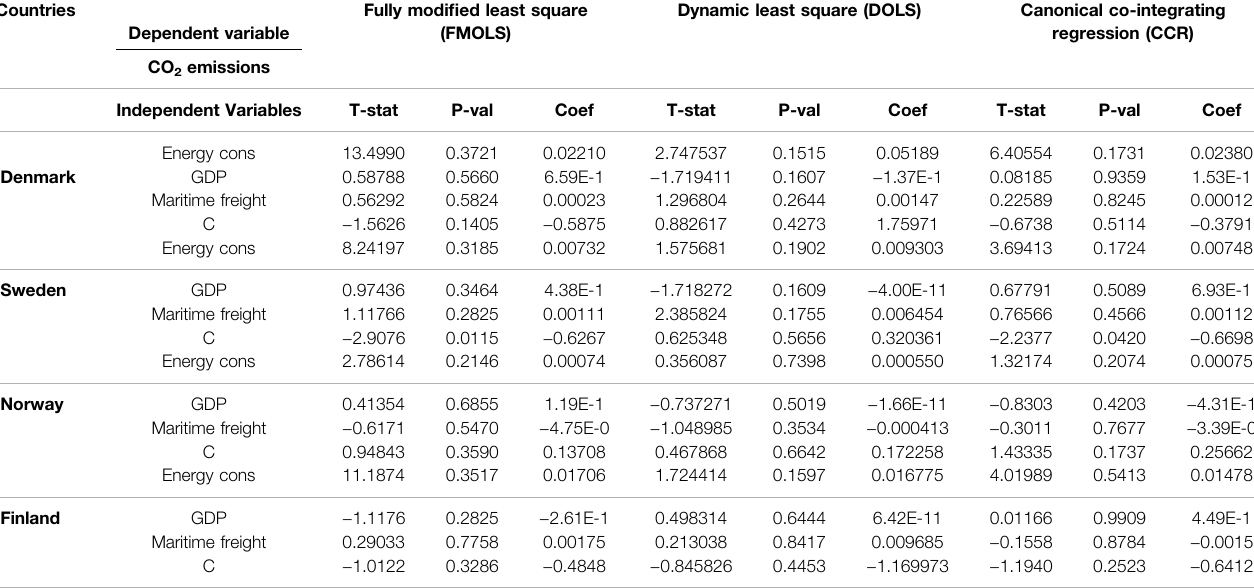
TABLE 8 | Co-integration estimation results of Scandinavian countries (1998 – 2015). Countries Fully modi fi ed least square